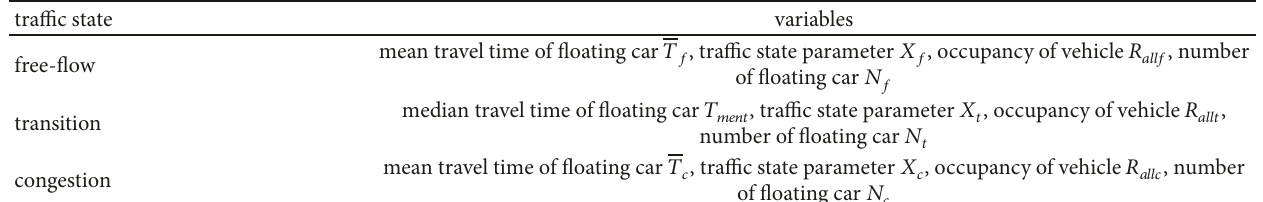
Table 10: The variables entering the model after eliminating multicollinearity.